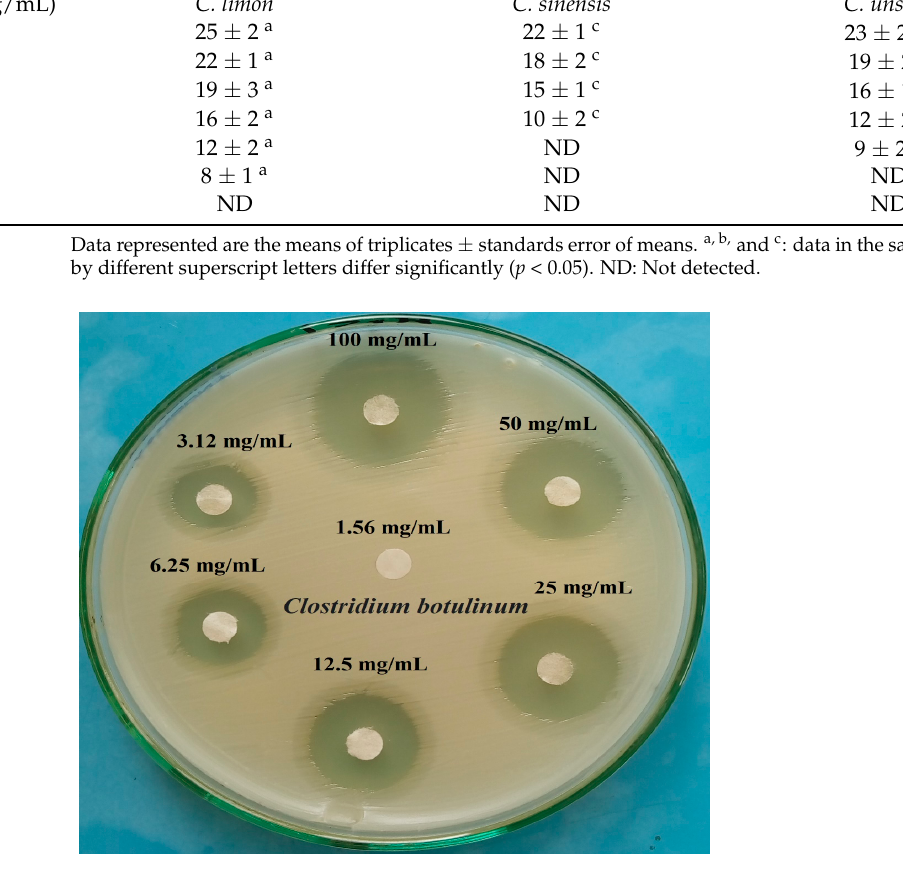
Figure 6. Minimum inhibitory concentrations (MICs) of Citrus limon leaf extract against C. botulinum type E using an agar disk diffusion assay.